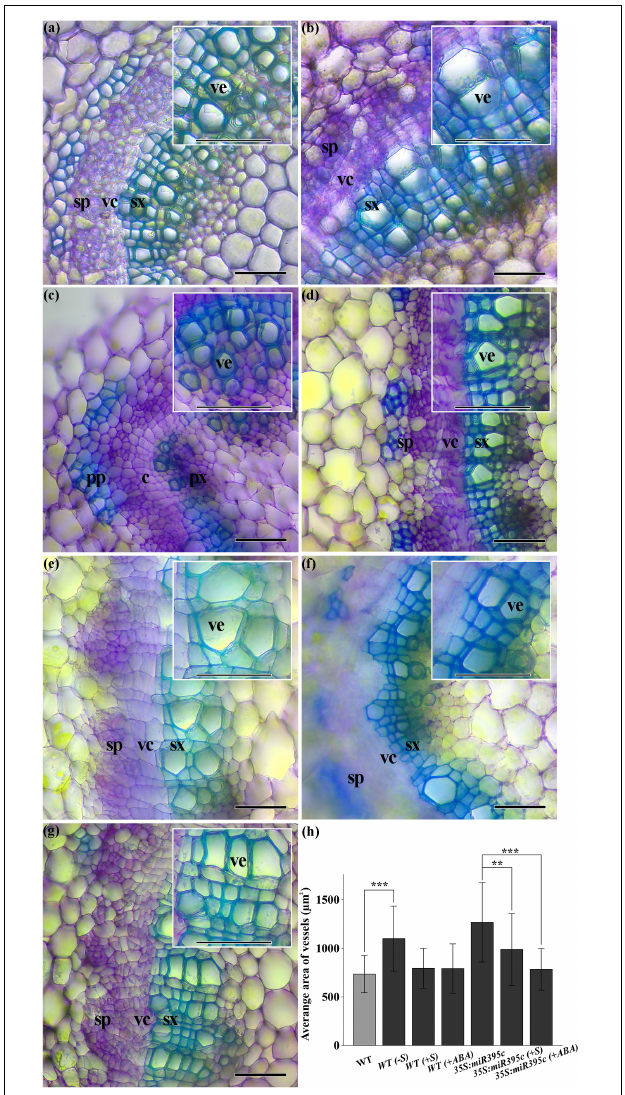
FIGURE 6 | Cross-sections of the 6th internode of 2-month-old wild-type and miR395c-OE 84K poplars treated with sulfur deficiency and sulfur or ABA surplus. (a) Cross-section of the wild type. (b) Cross-section of the wild type treated with sulfur deficiency. (c) Cross-section of the wild type added with sulfur. (d) Cross-section of the wild type added with ABA. (e) Cross-section of the miR395c-OE poplar. (f) Cross-section of the miR395c-OE poplar added with sulfur. (g) Cross-section of the miR395c-OE 84K poplar added with ABA. pp, primary phloem; px, primary xylem; c, cambium; vc, vascular cambium; sp, secondary phloem; sx, secondary xylem; ve, vessel. (h) Vessel dimension increased in wild type plants treated with sulfur deficiency and decreased in miR395c-OE plants added with sulfur or ABA. Bar, 50 µ m. Asterisks indicate significant difference between transgenic and WT plants using the Student’s t -test, ** p < 0.01; *** p < 0.001.